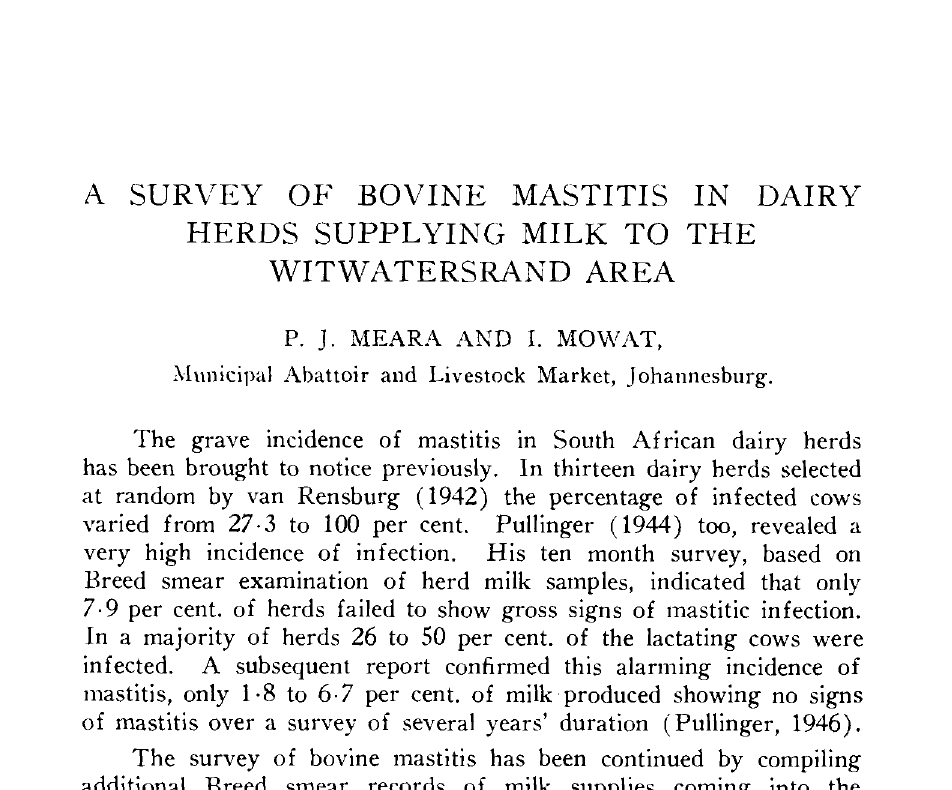
Ai onthly incidencc of mastItIs in a survey based UpOll Rrced smear examination of bulked milk